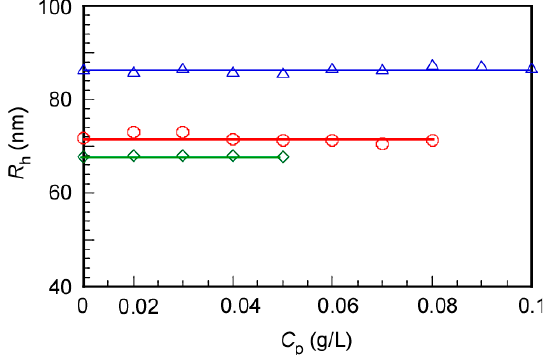
Figure 5. Hydrodynamic radius ( R h ) light scattering intensity (LSI) for the P(VS) 17 A 50 /PAAc 49 PIC vesicle with f + = 0.5 in water at pH 10 as a function of polymer concentration after mixing P(VS) 17 A 50 and PAAc 49 . The PIC vesicle solution at 0.1 (triangle), 0.08 (circle), and 0.05 (diamond) g/L were diluted with pH 10 aqueous solution at 25 ◦ C.